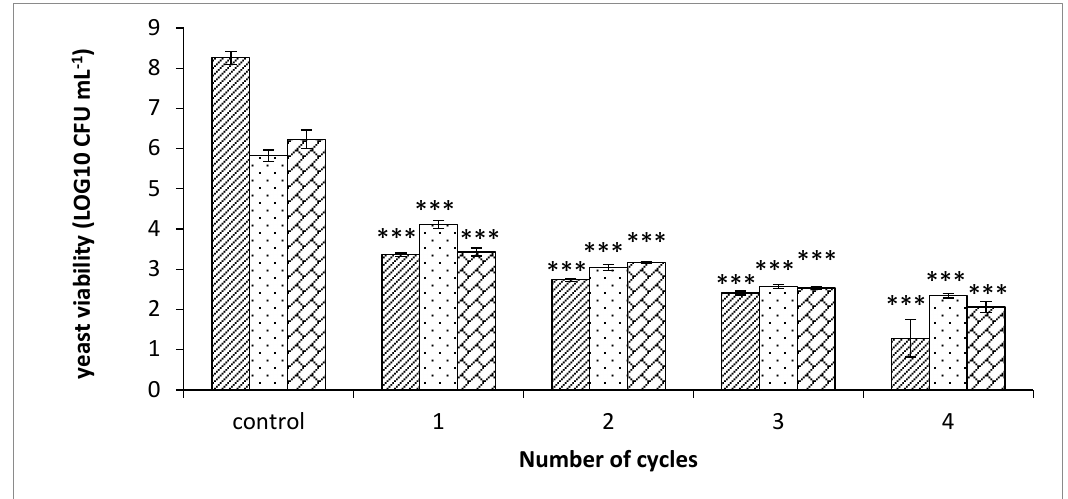
Figure 7. Viability of S. cerevisiae in YMBW after 24 h of incubation at 25 °C , as a function of PEF treatment cycle numbers and added preservatives. The control columns represent the CFU mL − 1 of yeast without PEF treatment. Column groups 1–4 represent the number of cycles that were applied to the yeast culture. No added preservatives ( ); added 25 ppm free SO 2 and 25 ppm sorbic acid ( ); added 50 ppm free SO 2 and 125 ppm sorbic acid ( ). The conditions of each PEF cycle: electric field intensity 2.9 kV cm − 1 , frequency 100 Hz, pulse duration 10 µs, conductivity 1200 µS cm − 1 . p value ( t test): *** p < 0.001.